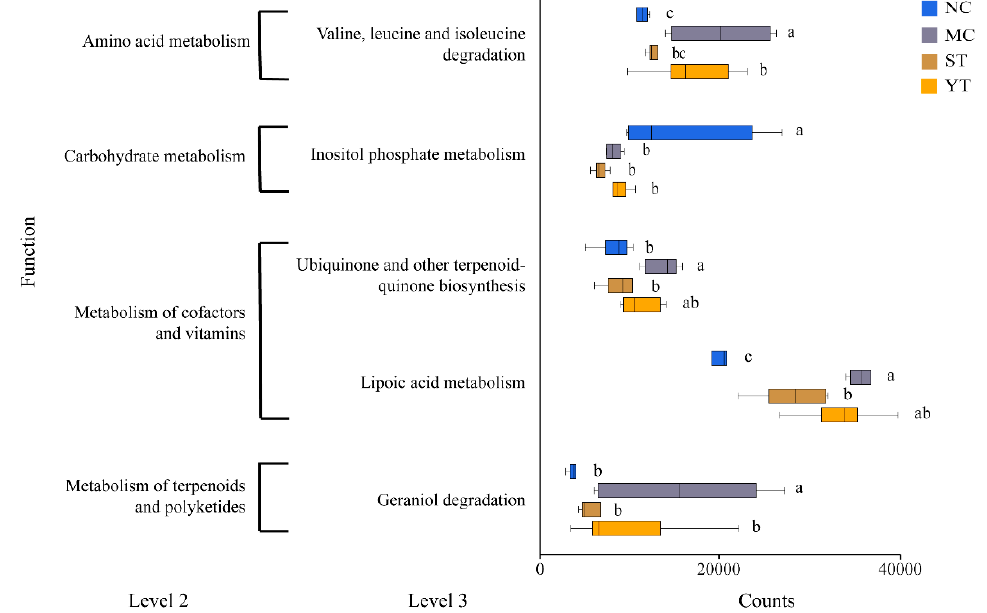
Figure 9. The predicted function of the fecal 16S metabolic pathway (significantly different in level 3 of the metabolic pathway). NC, Normal control group ( n = 6); MC, Model control group ( n = 6); ST, DMST-H2 treatment group ( n = 6); YT, yogurt treatment group ( n = 6). Significance was set as p < 0.05, and values that do not share a common letter differed significantly ( p < 0.05).